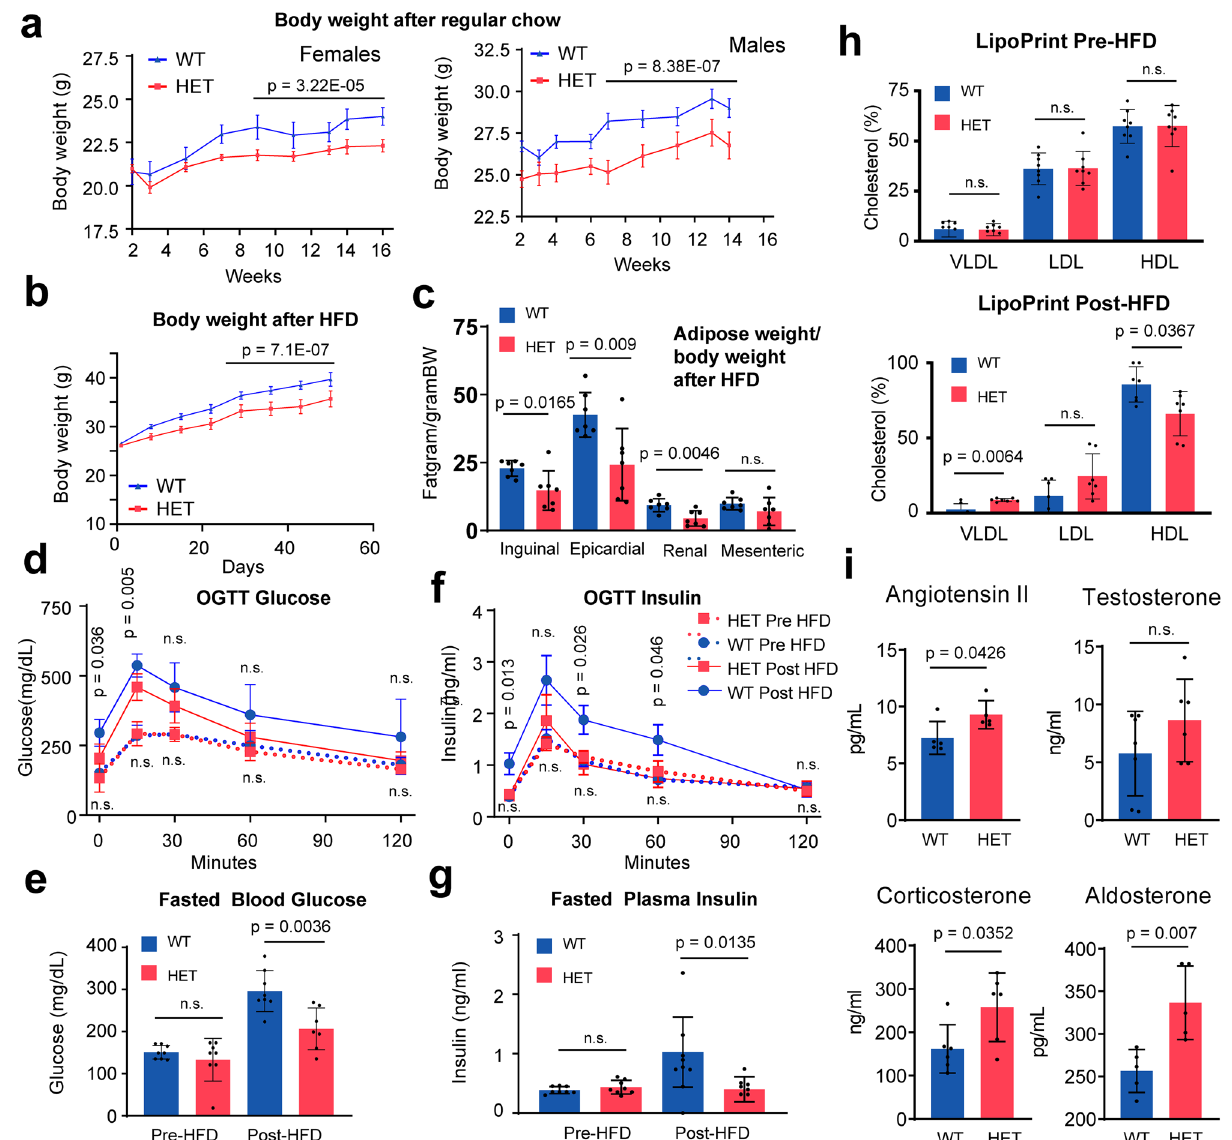
Figure 8. SAMD1 heterozygous (HET) mice gain less weight and have reduced adiposity, higher hormone levels, and different serum cholesterol levels. ( a ) Weight gain of WT and HET mice fed regular chow. Data are presented as the mean ± SE of at least 7 mice per condition. Significance was evaluated by a two-tailed unpaired Student’s t-test for the last 5 time points combined. ( b ) Weight gain of WT and HET mice fed regularly with high-fat diet (HFD). Data are presented as mean ± SE of at least 7 mice per condition. Significance was evaluated by a two-tailed unpaired student’s t-test. ( c ) Adipose weight upon HFD (n = 7). Data are presented as the mean ± SD of 7 mice per condition. P-value via two-tailed unpaired Student’s t-test. ( d ) Blood glucose concentration during oral glucose tolerance test, pre- or post-HFD. Data are presented as mean ± SE of at least 7 mice per condition. P-values via two-tailed unpaired student’s t-test. ( e ) Fasted Blood Glucose level pre- or post-HFD. Data are presented as the mean ± SD of at least 7 mice per condition. Significance was evaluated by a two-tailed unpaired Student’s t-test. ( f ) Serum insulin during the oral glucose tolerance test, pre- or post-HFD. Data are presented as the mean ± SE of at least 7 mice per condition. Significance was evaluated by a two-tailed unpaired Student’s t-test. ( g ) Fasted plasma insulin pre- or post-HFD. Data are presented as the mean ± SD of at least 7 mice per condition. Significance was evaluated by a two-tailed unpaired Student’s t-test. ( h ) Serum cholesterol levels before and after an HFD. Data are presented as mean ± SD of 7 mice per condition. P values via two-tailed Mann–Whitney U test. ( i ) Levels of metabolic hormones in WT and HET mice. Data are presented as mean ± SD of at least 5 mice per condition. P-values via two-tailed unpaired Student’s t-test. n.s. = not